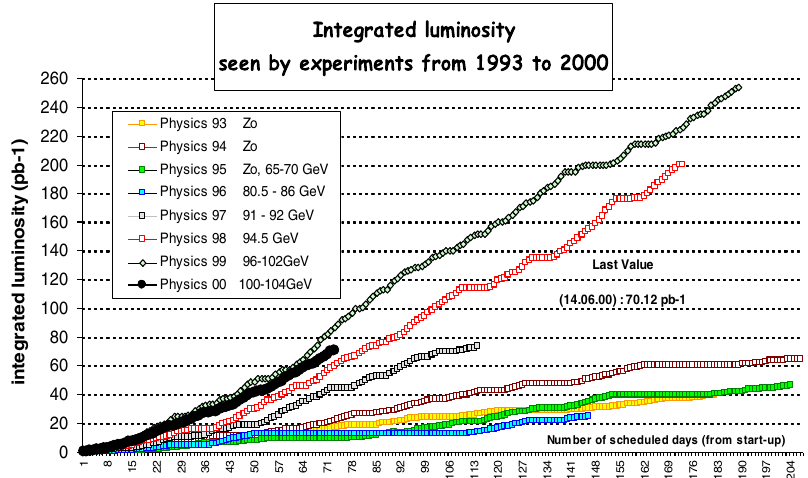
FIG. 26. LEP daily integrated luminosity from 1993 to